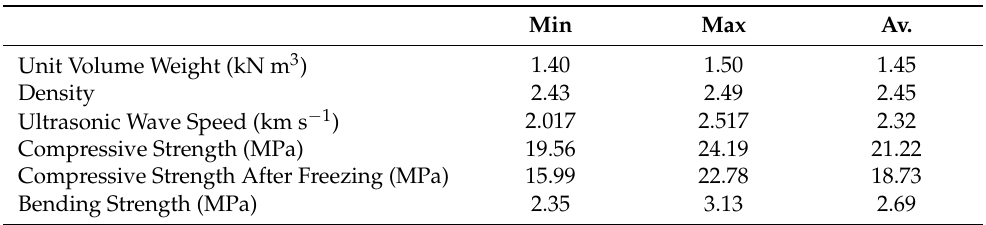
Table 2. Material properties used in the model (Celik and Gaye, 2016; Aslan and Aslan, 2016). Structural Element